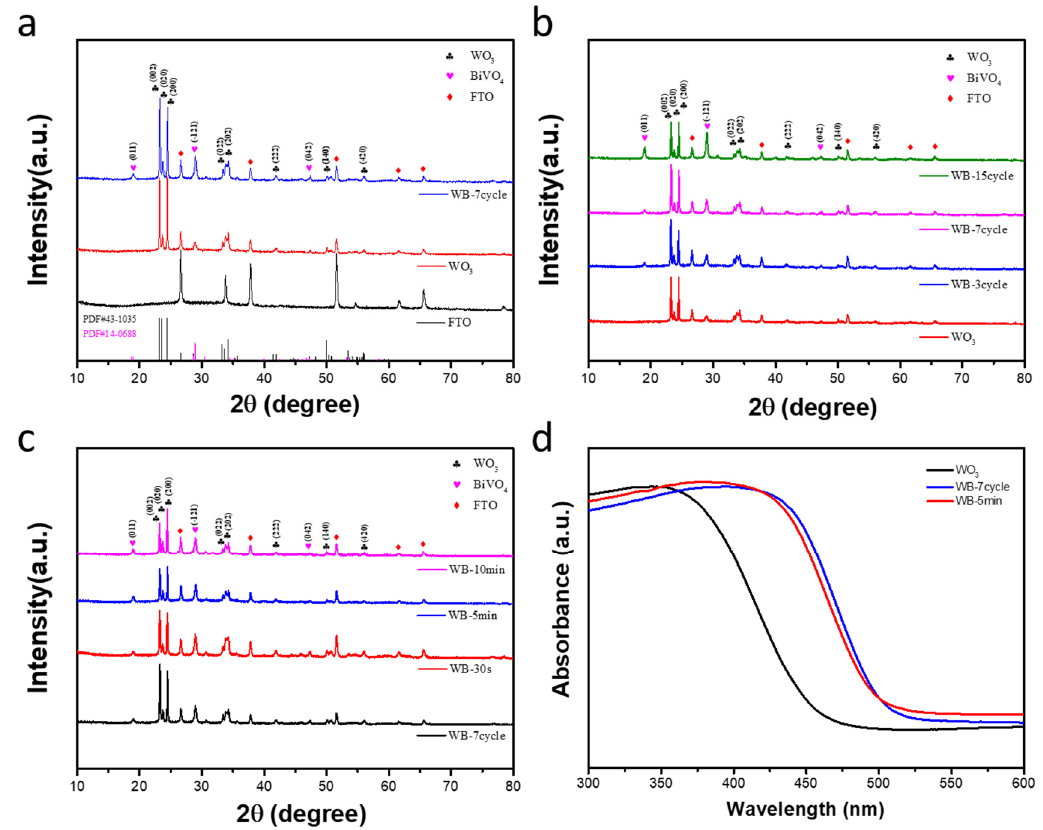
Figure 3. XRD patterns of ( a ) FTO substrate, WO 3 nanoflakes and WB-7cycle samples with standard XRD peaks of WO 3 and BiVO 4 , ( b ) WO 3 nanoflakes, WB-3cycle, WB-7cycle, and WB-15cycle and ( c ) WB-7cycle, WB-30s, WB-5min, and WB-10min samples. ( d ) UV-vis absorbance spectra of WO 3 nanoflakes, WB-7cycle, and WB-5min.